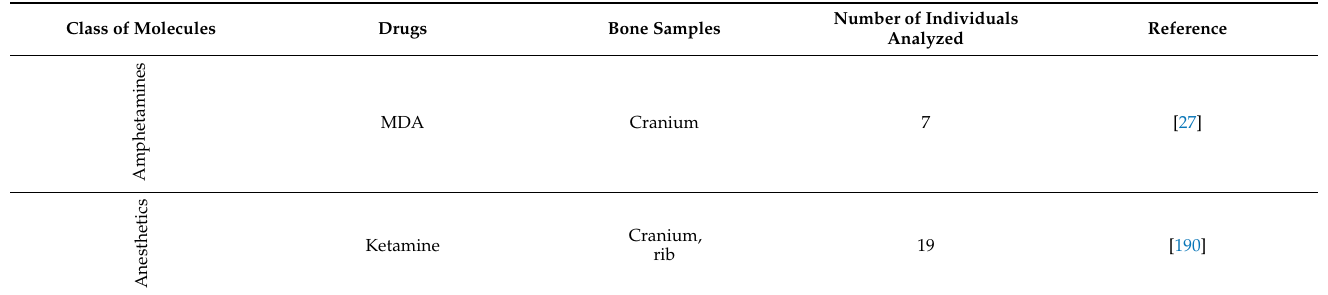
Table 3. Table that summarizes substances so far detected in bone through toxicological analyses in different studies. The table lists the substances, the study, the site of sampling, and the number of skeletons analyzed in the